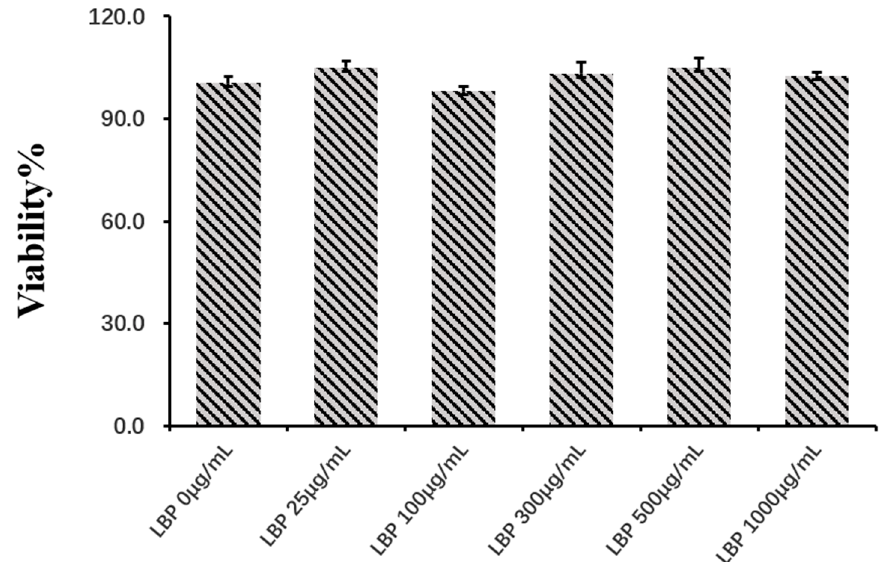
Figure 1. Determination of cell viability in different doses of LBP via CCK-8 assay. Effects of LBP on pbMEC viability. pbMEC were treated with different concentrations of LBP at 0, 25, 100, 300, 500, and 1000 μ g/mL for 24 h. Determination of cell viability in different doses of LBP via Cell Counting Kit-8 assay. Results are presented as means ± SEM. Superscripts represent that the difference between groups was significant according to statistical analysis ( p < 0.05).